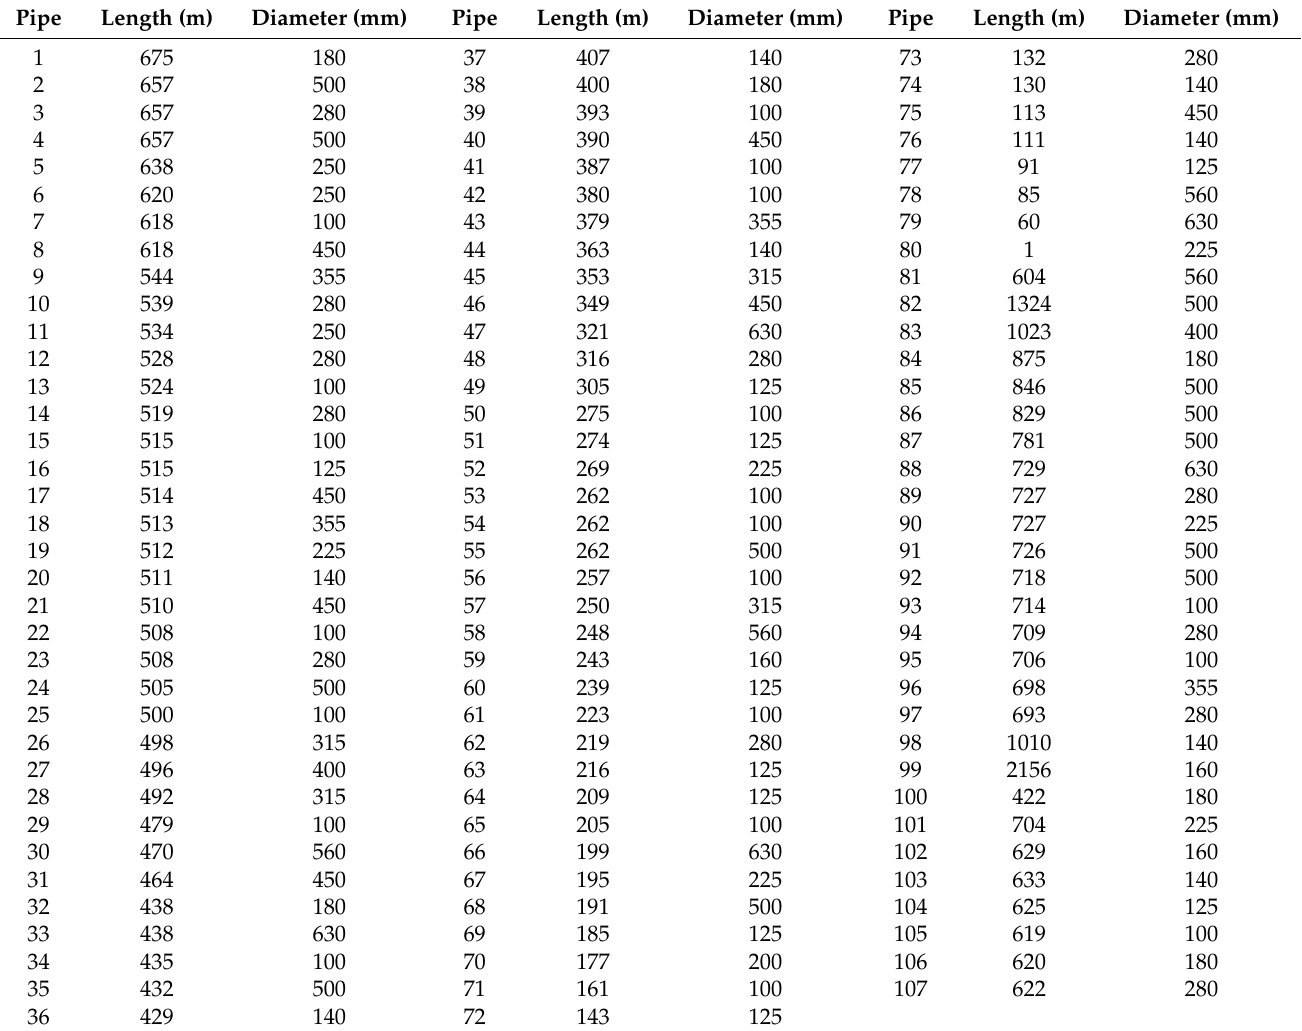
Table 2. Information on Baharestan’s network